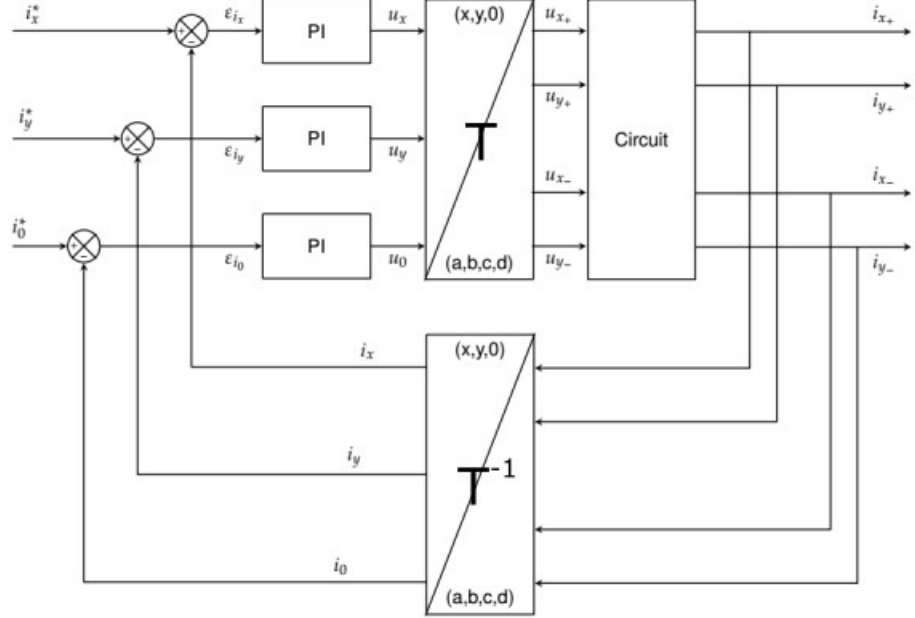
Figure 5. Block diagram showing the described transformation and anti-transformation of the